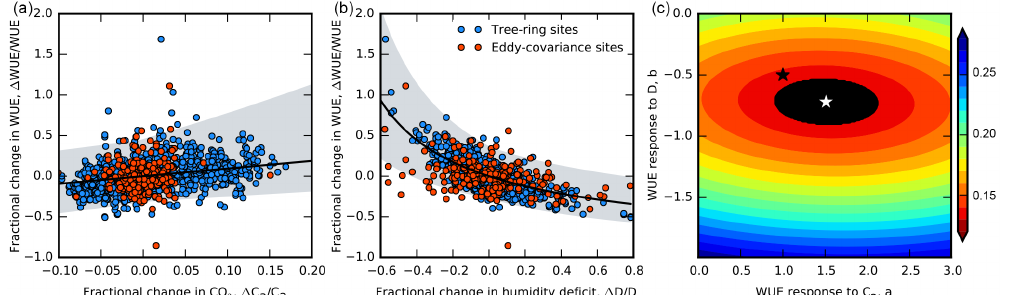
Figure 2. Water-use efficiency (WUE) from tree-ring and eddy covariance observations. The relationship between the observed fractional change in WUE and the fractional change in (a) CO 2 concentration and (b) humidity deficit of both datasets is fitted to Eq. (3),with best-fit values for a (1.51 ± 0.57) and b ( − 0.72 ± 0.16). (c) The colours show the root mean square error (RMSE) of the simulated vs. observed fractional change in WUE as a function of a and b , with the black area representing the best parameters within 5% of the RMSE of the best fit (white star). The black star represents the values according to the optimality hypothesis.